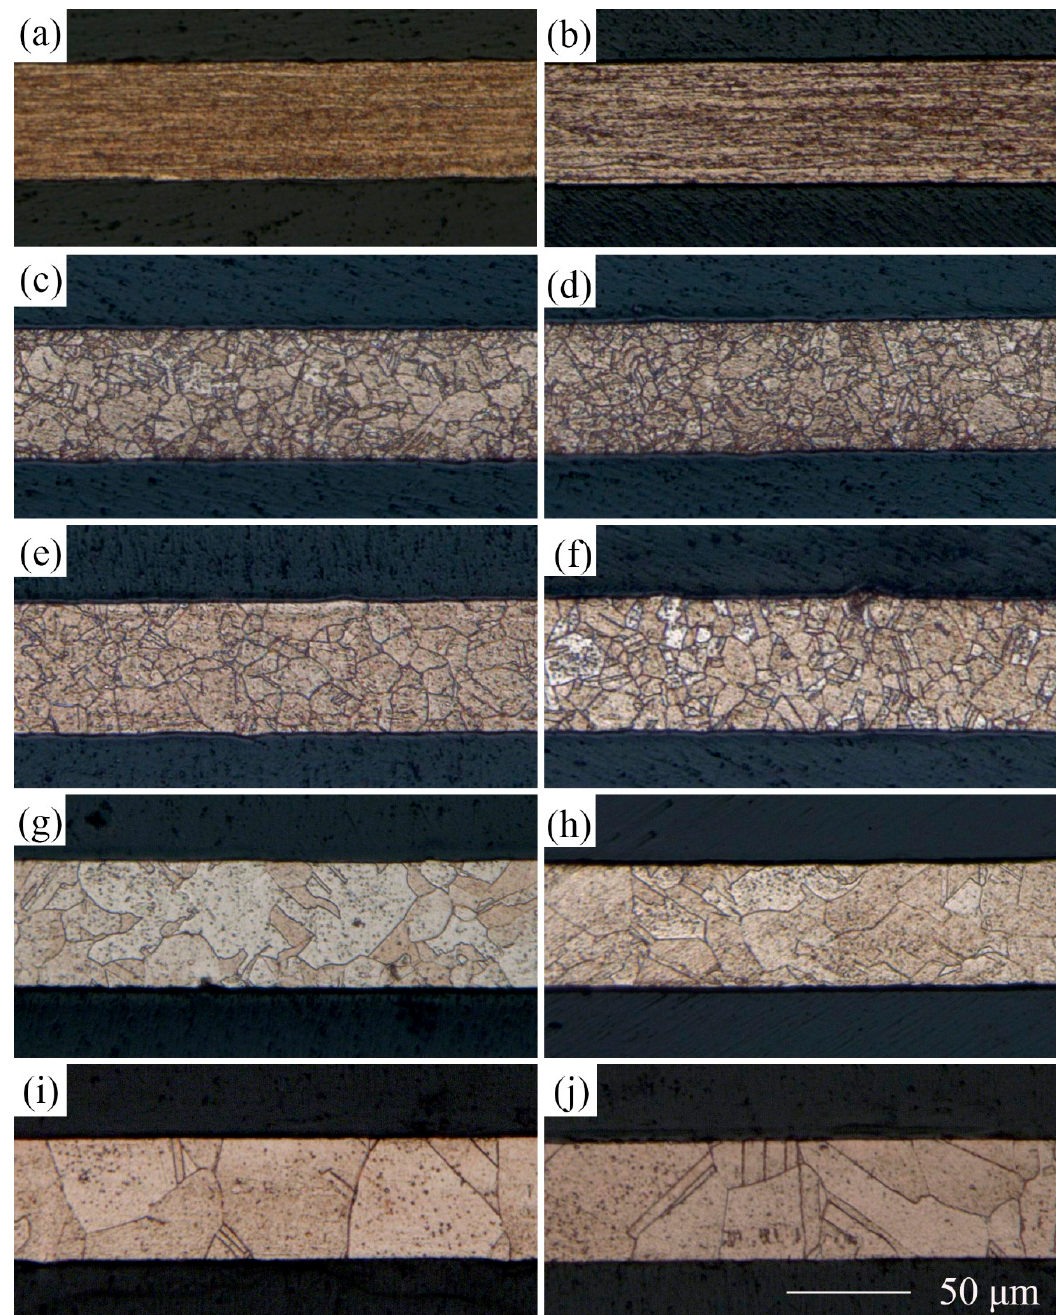
Figure 4. Microstructures of the copper foils with and without LPS under different annealing treatment. ( a ) without LPS, cold-rolled; ( b ) with LPS, cold-rolled; ( c ) without LPS, 350 °C, 1 h; ( d ) with LPS, 350 °C, 1 h; ( e ) without LPS, 450 °C, 1 h; ( f ) with LPS, 450 °C, 1 h; ( g ) without LPS, 550 °C, 1 h; 1 h; ( e ) without LPS, 450 ◦ C, 1 h; ( f ) with LPS, 450 ◦ C, 1 h; ( g ) without LPS, 550 ◦ C, 1 h; ( h ) with LPS, ( h ) with LPS, 550 °C, 1 h; ( i ) without LPS, 650 °C, 1 h; ( j ) with LPS, 650 °C, 1 h. 550 ◦ C, 1 h; ( i ) without LPS, 650 ◦ C, 1 h; ( j ) with LPS, 650 ◦ C, 1